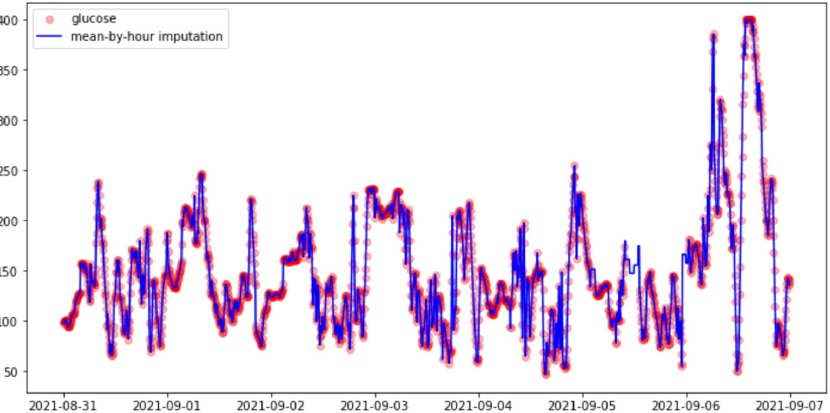
Figure 5. Comparing the true CGM time series with the imputed CGM using hourly mean, in one week period for patient 588.